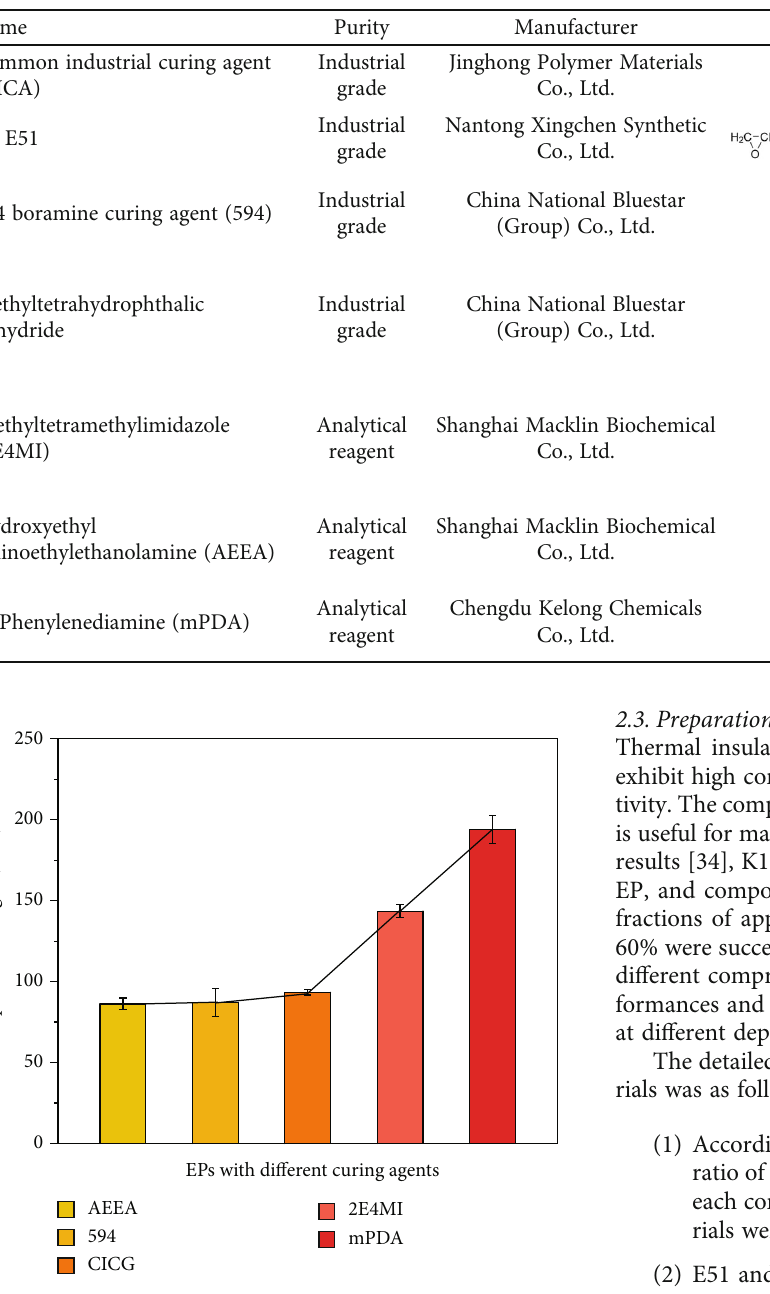
Figure 1: Compressive strengths of EP matrixes prepared with di ff erent curing agents. The compressive strengths of EP cured by AEEA, 594, CICA, 2E4MI, and mPDA were